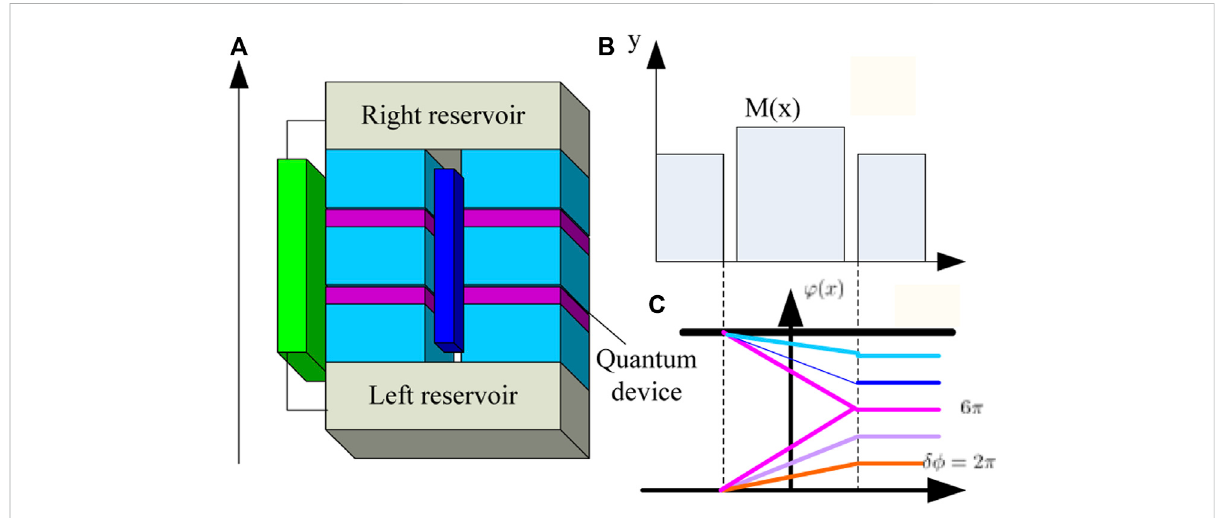
FIGURE 2 (A) Schematic of the three-dimensional quantum device interface with two-layer localized system evolution with a coupling scale factor. (B) Pairing spatial pro fi le for amplitude and tunneling strength M(x) induced by the superconductors and insulator. (C) Energy band and band gap diagram along the high-symmetry